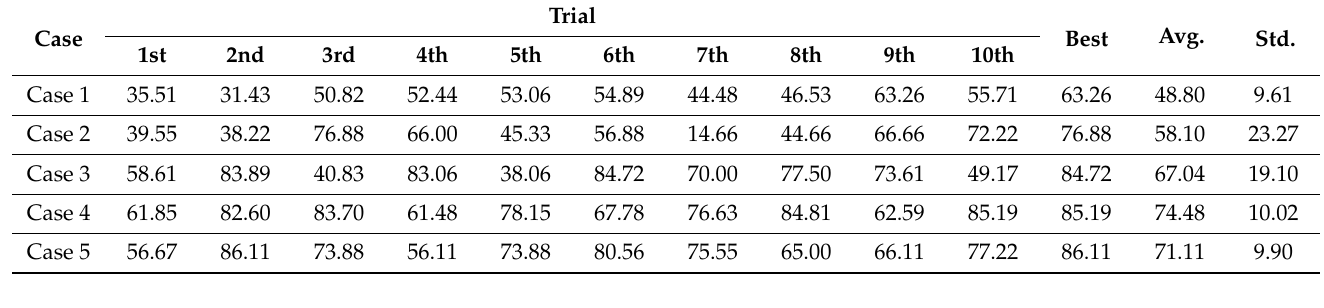
Table 4. Recognition accuracy without attention layer.